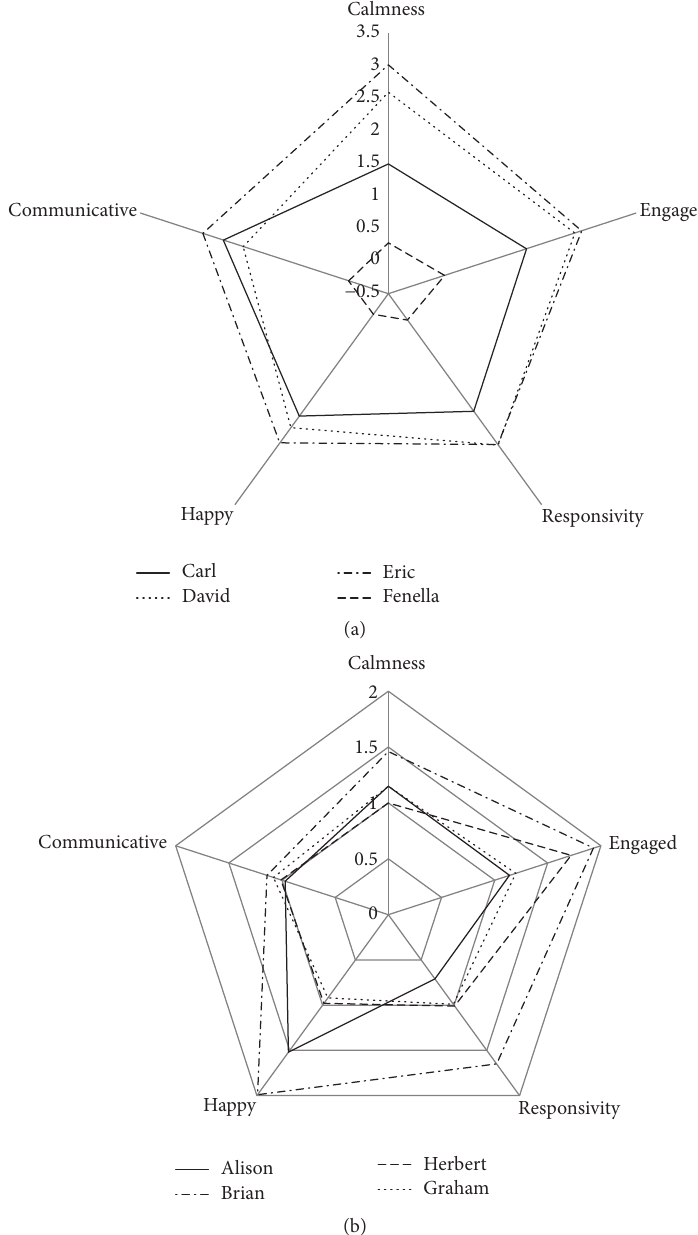
Figure 1: Radar plot of mean change in five rating scales (happy, communicative, calmness, engaged(-ness), and responsivity) for each of the eight participants. The radar plot shows the 5 ratings for each participant, such that the distance from the centre (at which point the change in rating scale = − 0.5, i.e., a deterioration) indicates the magnitude of the changes. If every participant made an equal improvement the shapes would be regular pentagons. Rating scales are designed to display positive values for improved functioning in that